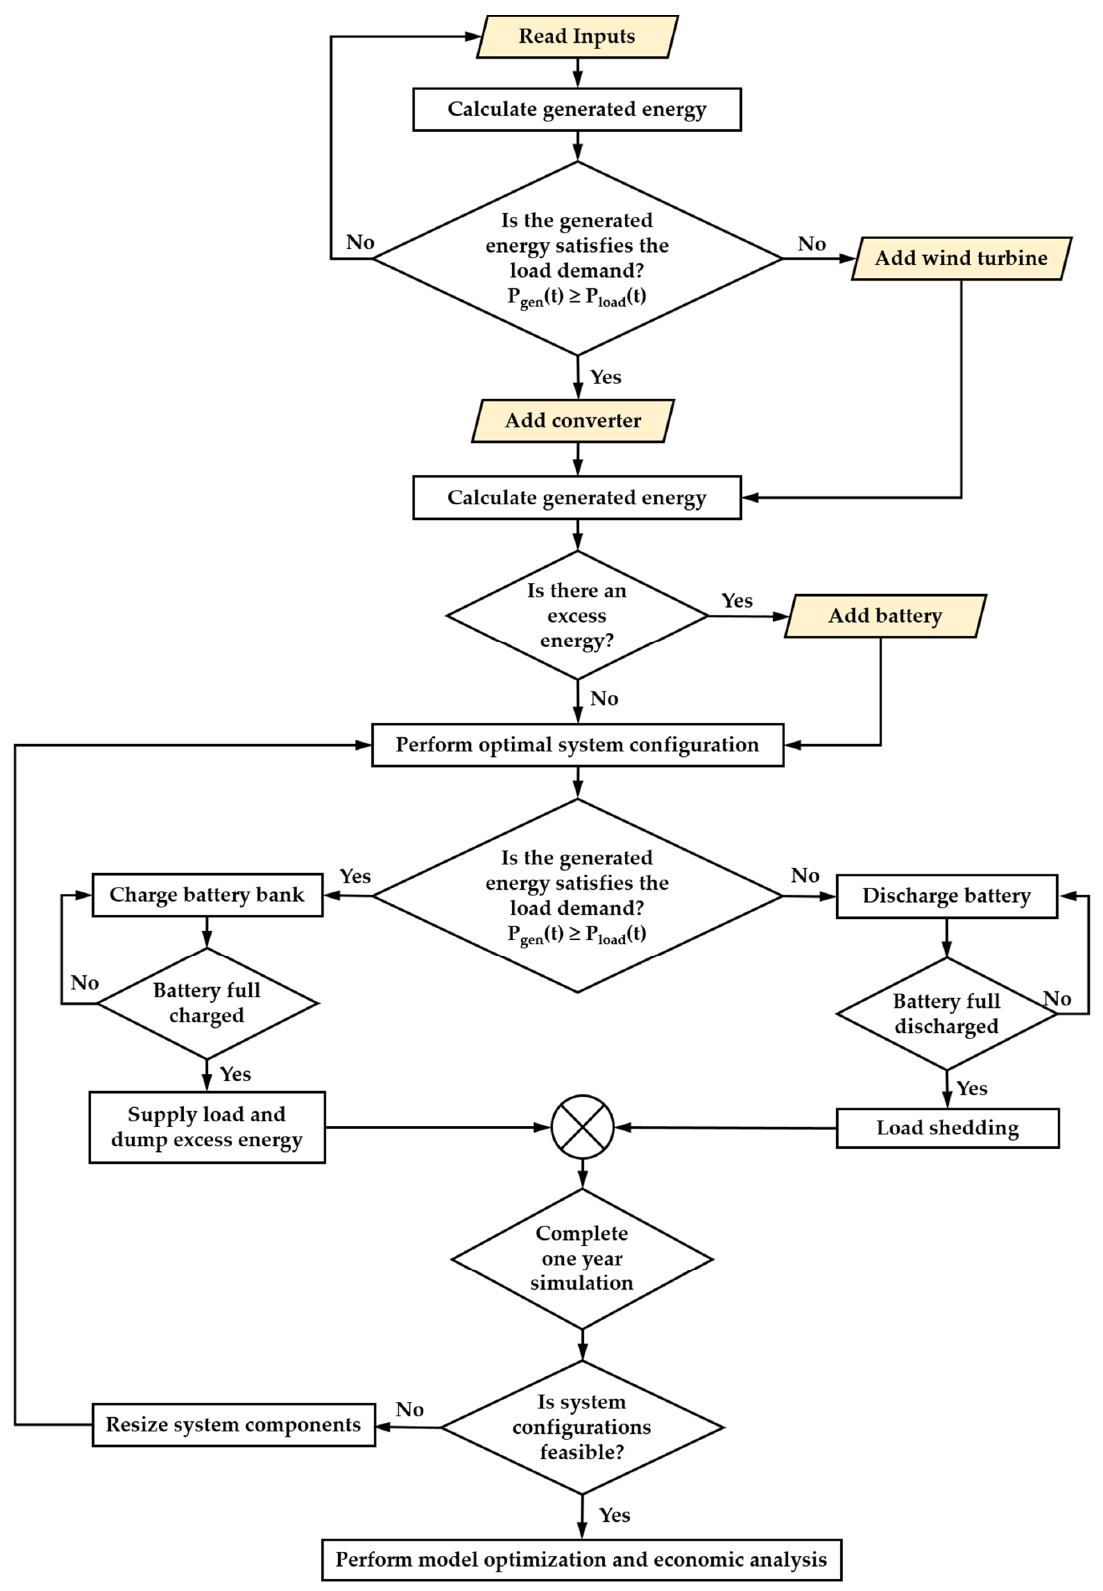
Figure 5. Flowchart for the techno-enviro-economic analysis and control strategy of Absolute Transition Scenario (ATS).